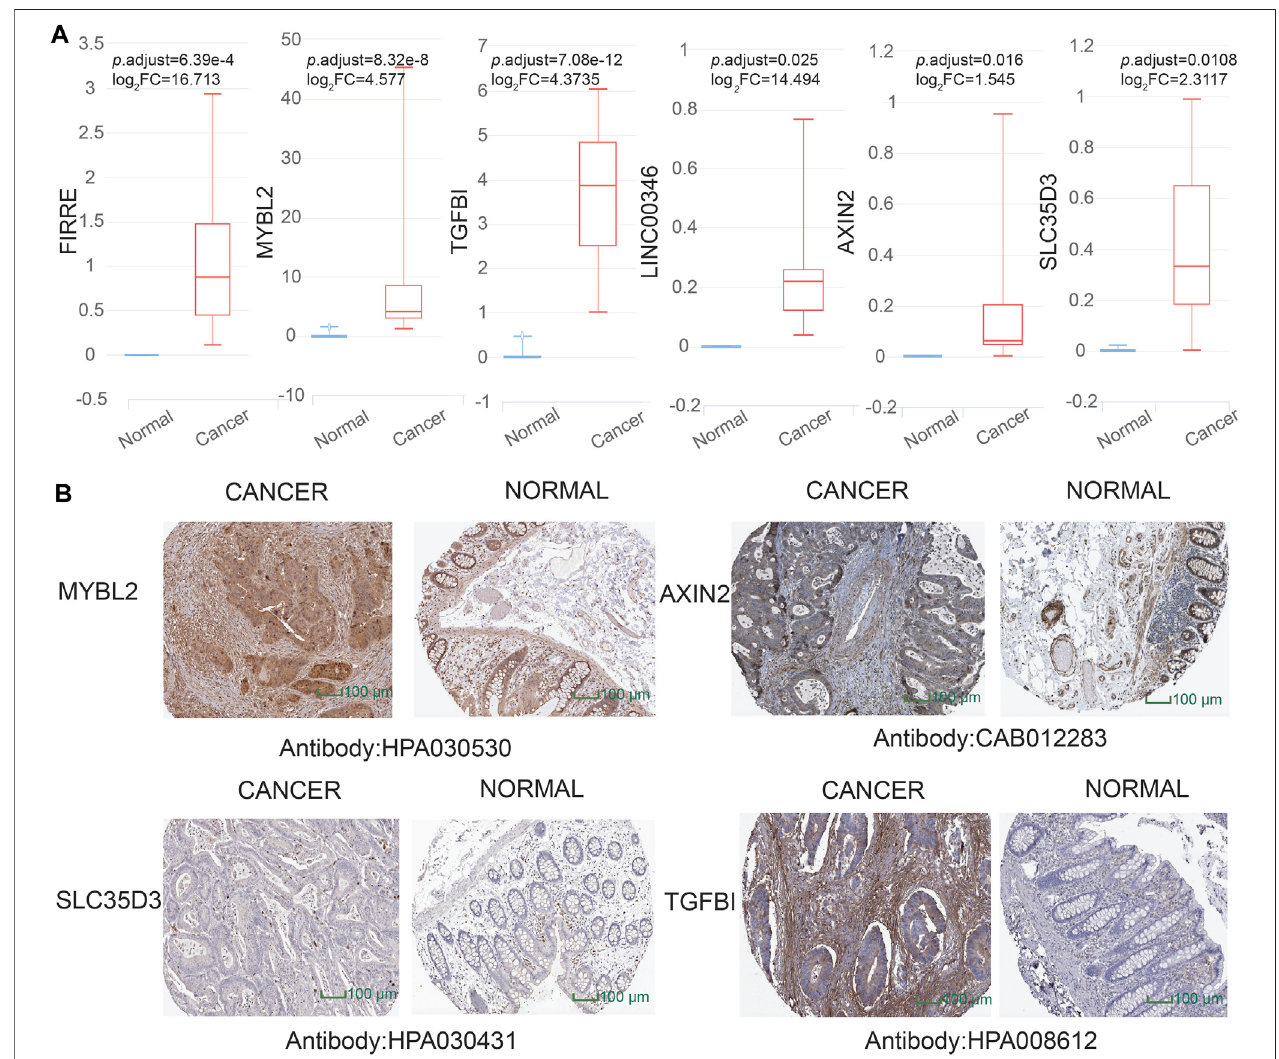
FIGURE 5 | Assessment of preliminary shortlisted candidate gene expression level in extracellular vesicles (EVs) and immunohistochemistry. (A) Highly expressed methylation-driven genes (FIRRE, MYBL2, TGFBI, LINC00346, AXIN2, and SLC35D3) in EVs for cancer samples. (B) Higher protein expression of immunohistochemistry (MYBL2, AXIN2, TGFBI, and SLC35D3) in cancer tissue than normal tissue from the Human Protein Atlas (HPA) project database (https://www. proteinatlas.org/).